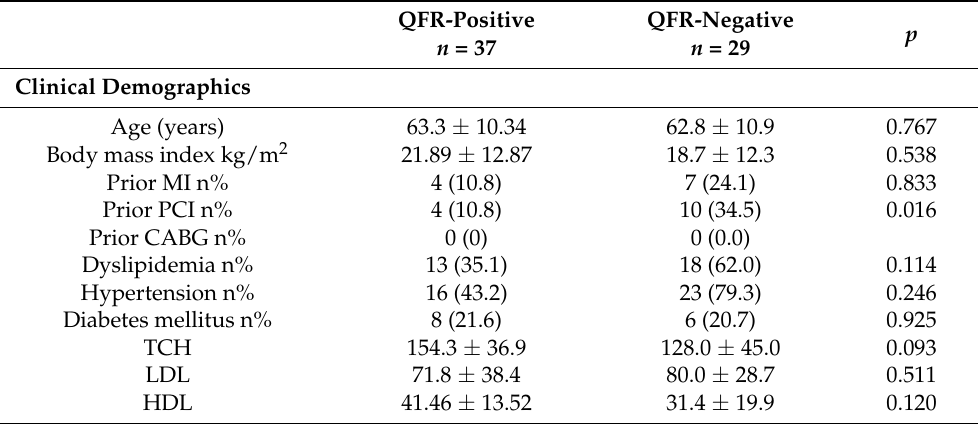
Table 1. Patient